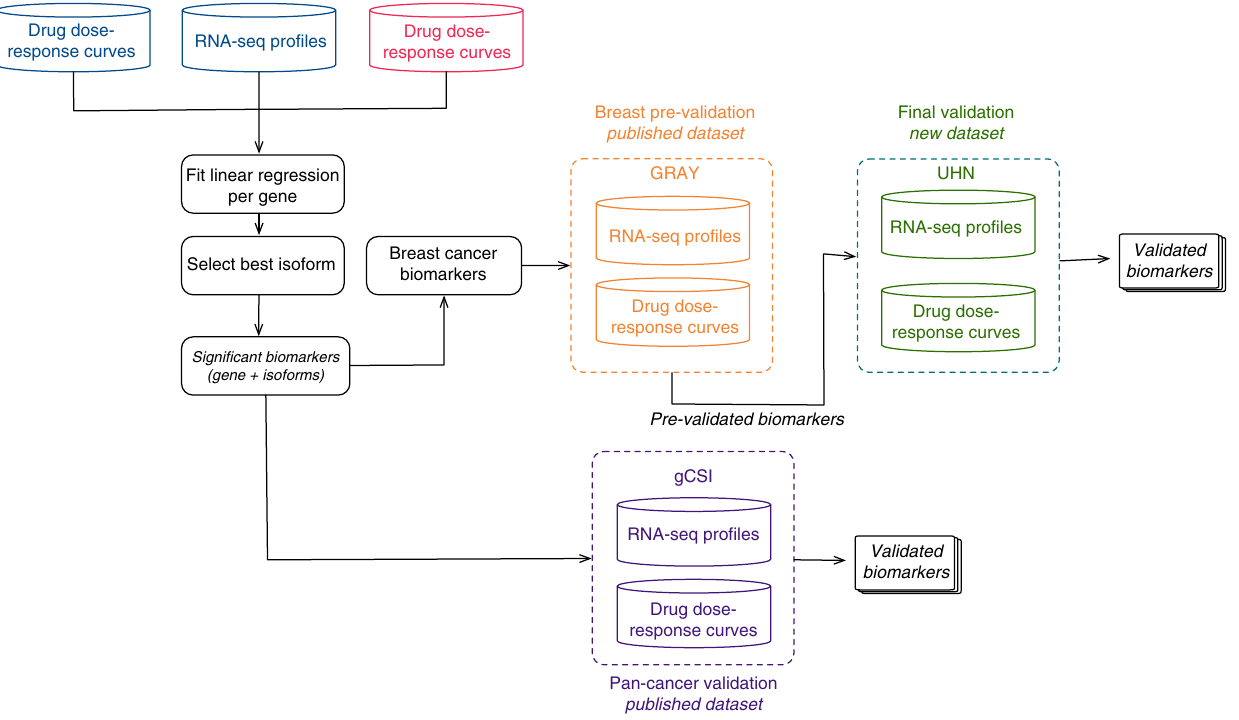
Fig. 1 Analysis design of the study. CCLE (in blue) and GDSC (in red) are used to identify a set of biomarkers signi fi cantly associated with response to each of the 15 drugs screened in both training sets. Candidate biomarkers are tested both in pan-cancer (gCSI in purple) and in breast cancer-speci fi c (GRAY in orange and UHN in green) settings. The validation in GRAY is referred to as pre-validation, enabling the selection of generalizable, isoform-based biomarkers for breast cancer. The newly generated UHN dataset is then used to test whether the selected isoform-based biomarkers are robust to the use of a different pharmacological assay ( fi nal